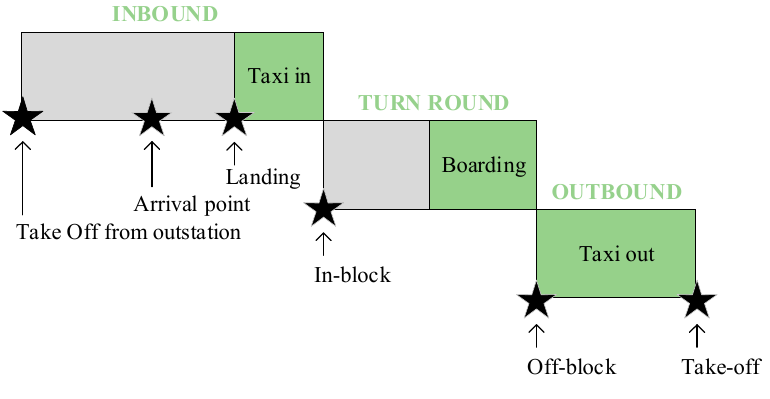
Figure 1. Transit flight guarantee process.